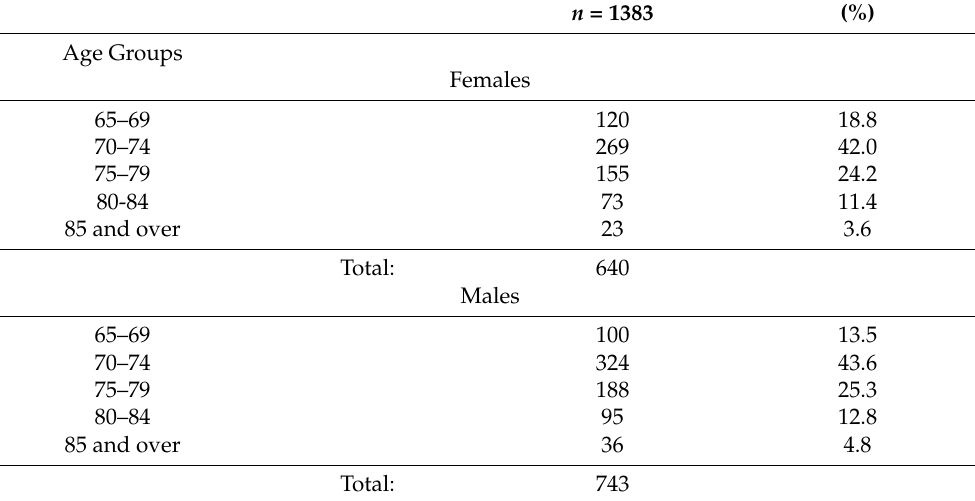
Table 1. Age distribution by gender